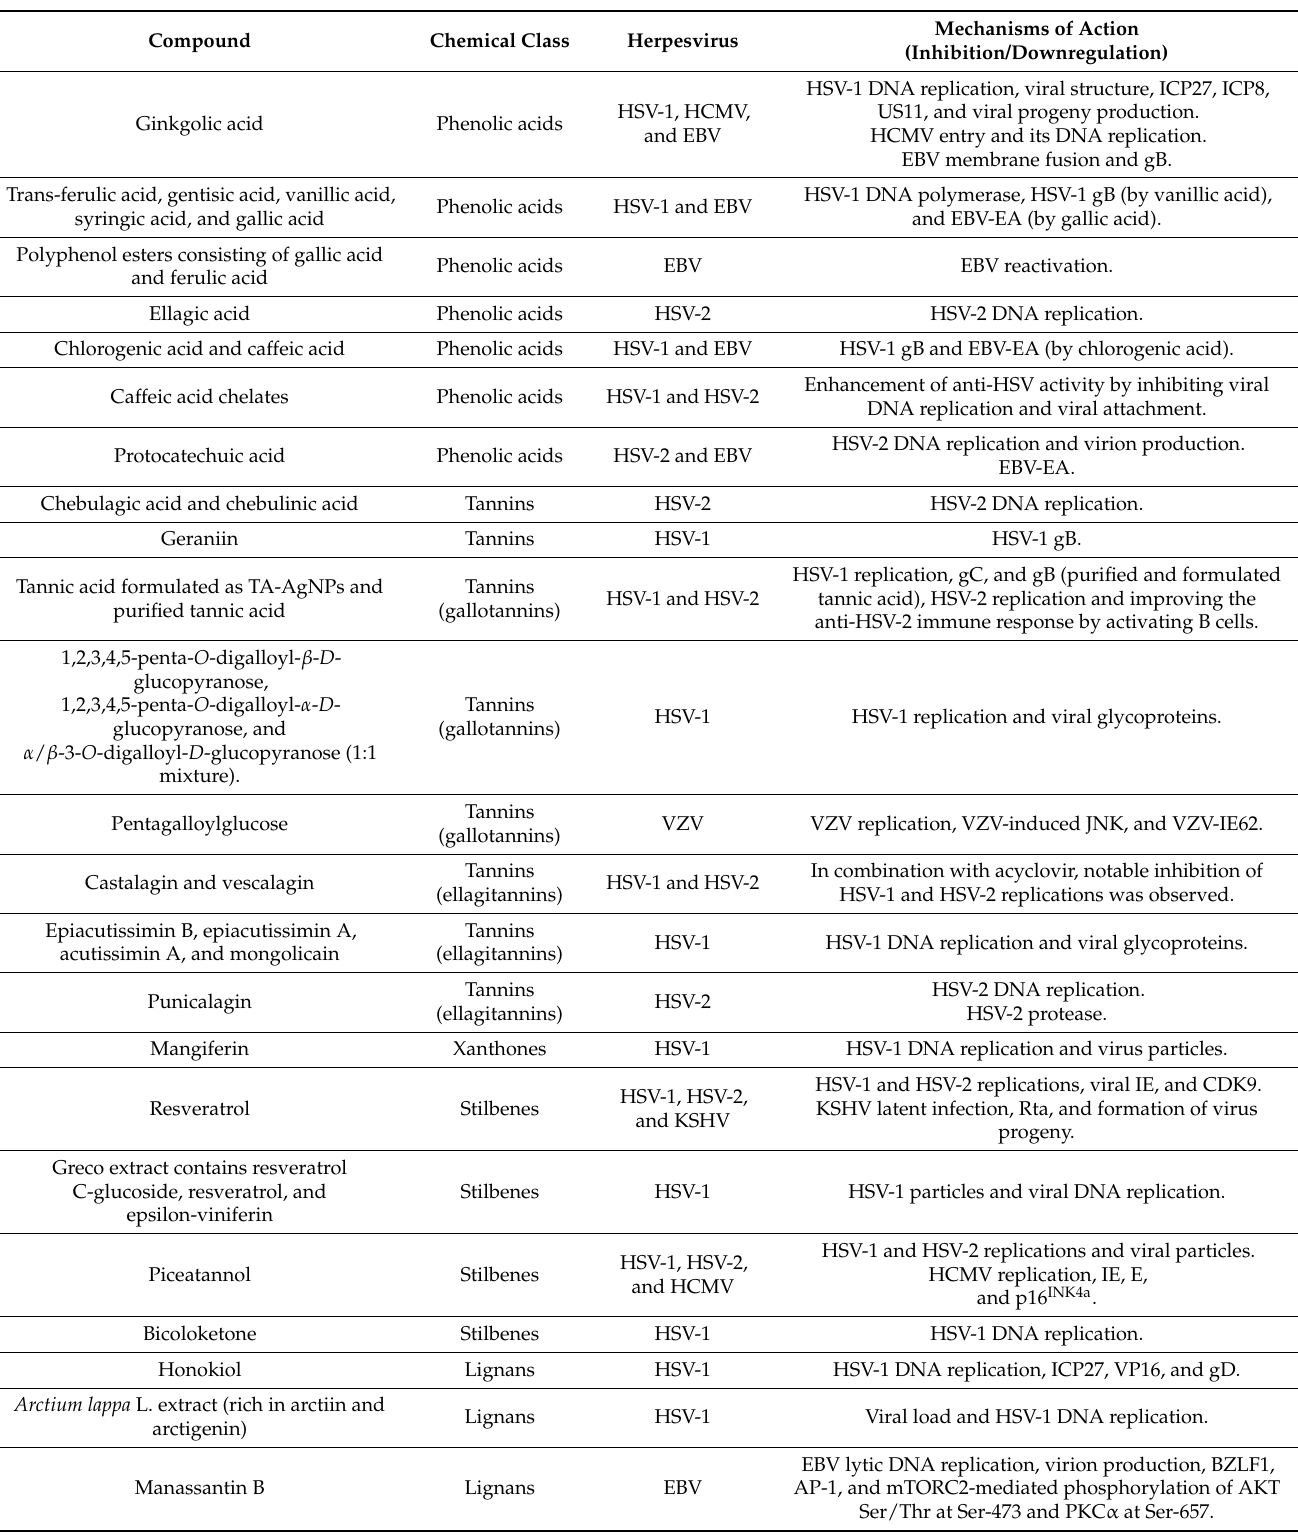
Table 1. A focus insight into the reviewed non-flavonoid polyphenols, summarizing their mechanisms of action against human alpha-, beta-, and